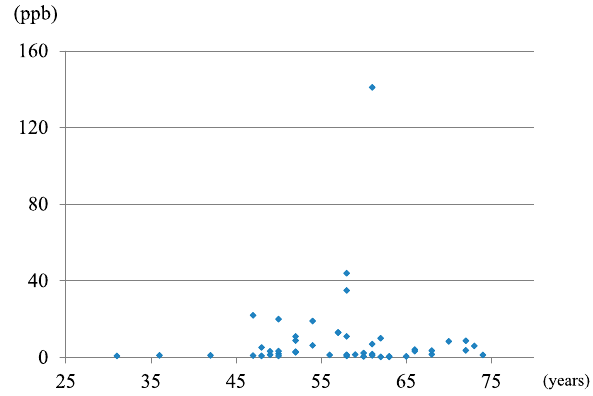
Figure 1 Serum cobalt ion concentration and age of patients at operation The mean age of the patients at the time of surgery was 57.1 (range, 31– 74) years, and no correlation was observed with the serum cobalt ion concentration.